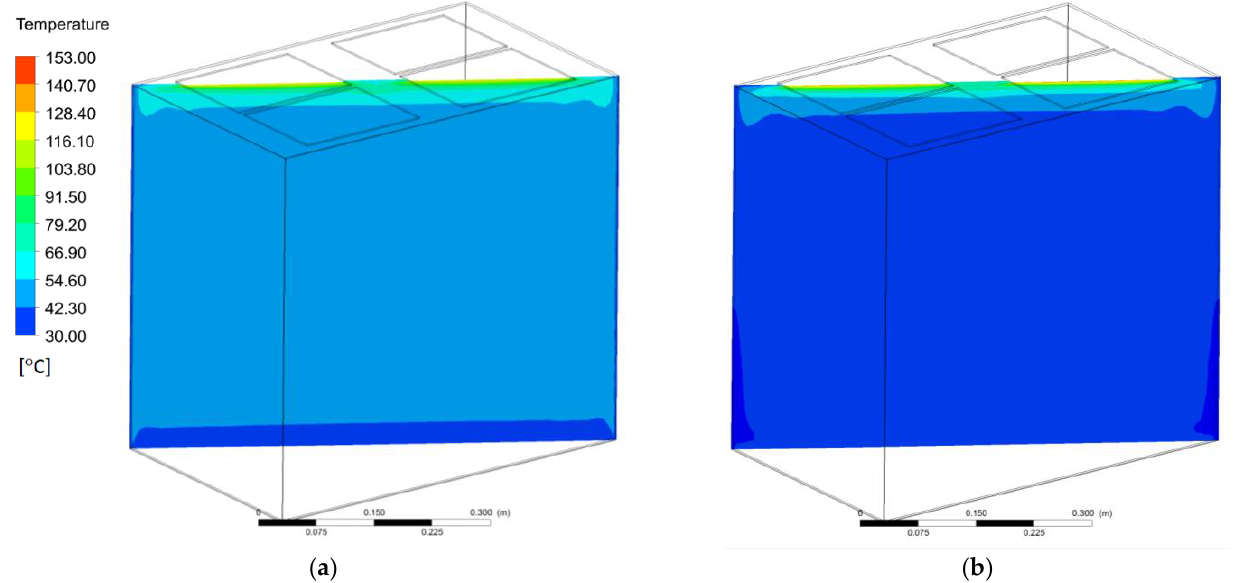
Figure 3. Temperature distribution in the cross section of the modelled structure for the dome walls made of ( a ) insulating (case a) and ( b ) conducting (case b) materials.